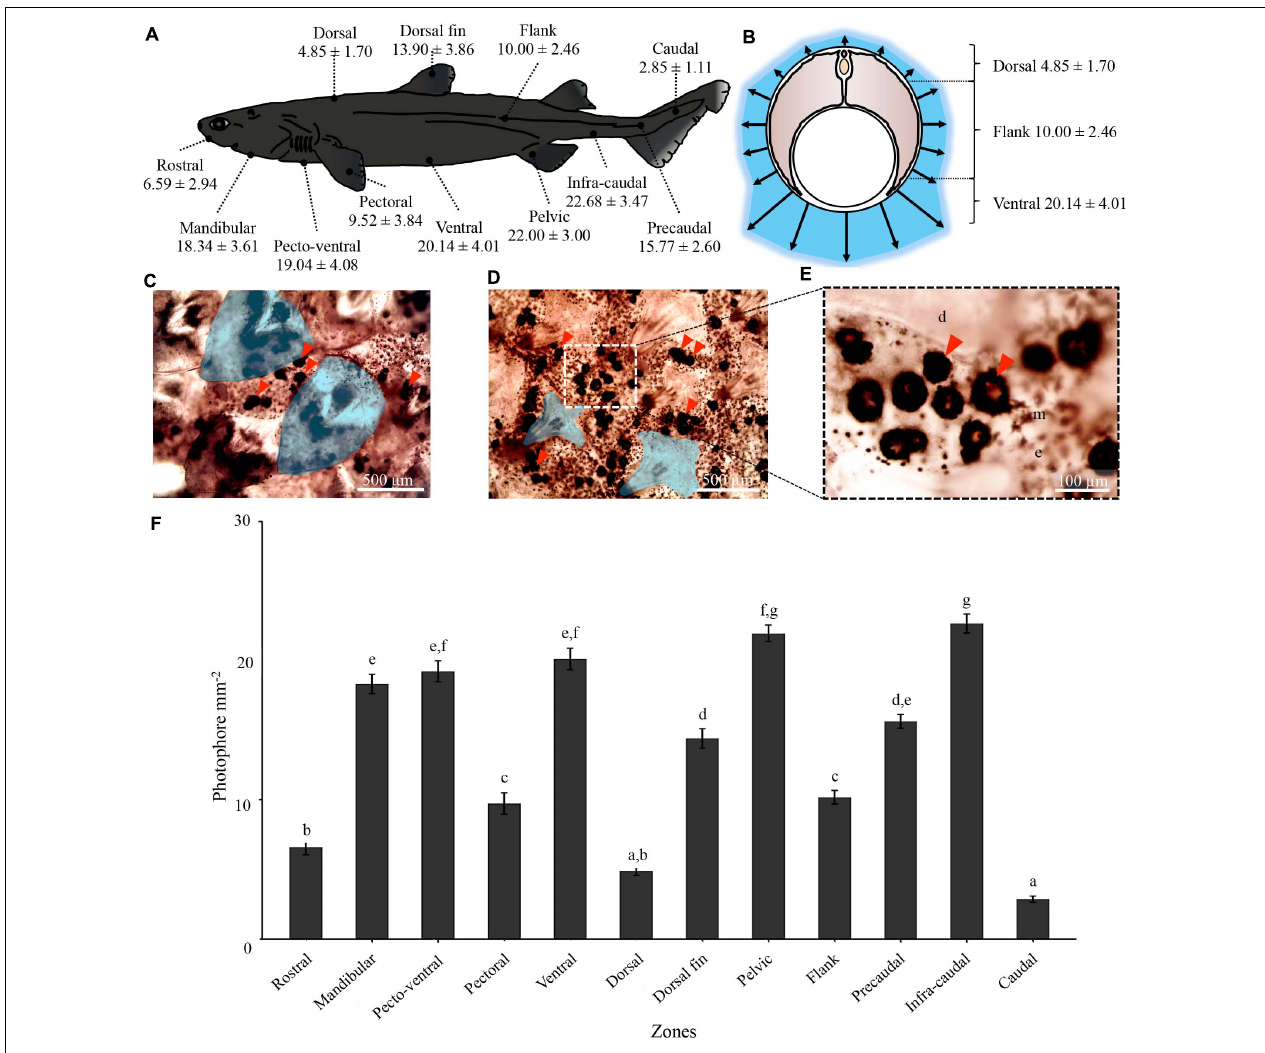
FIGURE 1 | Dalatias licha photophore visualization and density measurements. (A) Photophore densities for each studied zone along the shark body. (B) Representation of the dorso-ventral photophore density gradient. Black-dotted photophores (red arrowhead) observed between the placoid scales (delimited areas) at the (C) rostral and (D) ventral areas. Rostral area presents specific leaf-shaped placoid scales, while ventral area harbors typical pavement type placoid scales. (E) Close-up of the black circular-shaped photophores within the integument surrounding the ventral placoid scales. d, placoid scale; e, epidermis; m, melanophore; p, photophore. (F) Photophore density variation across the studied zones. Different lettering indicates statistical differences. All density values are expressed as mean ±